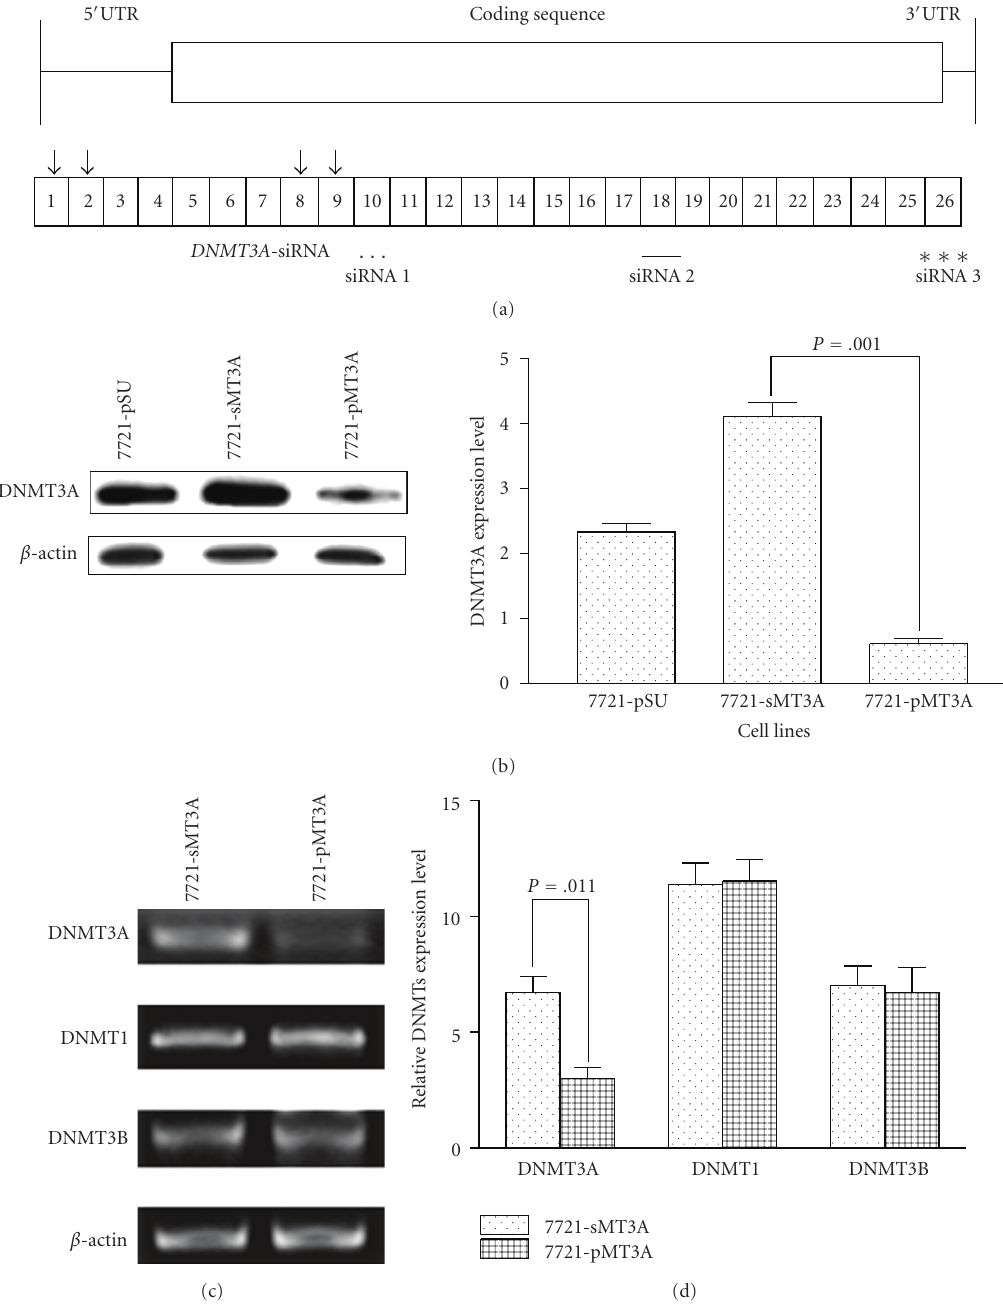
Figure 2: DNMT3A gene expression is inhibited by siRNA of DNMT3A in SMMC-7721 cells. (a) Schematic representation of DNMT3A mRNA structure and siRNA positions is showed. (b) Western blot analysis e ffi ciency of DNMT3A siRNA, β -actin was used as reference control. Lanes 1–3 indicated the cell line transfected with plasmid pSUPER-EGFP, sMT3A, and pMT3A, respectively. Right: the intensity ratios of both target gene band and control from the same sample were determined and calculated by Gel-Pro Analyzer 3.0 . (c) RT-PCR evaluated the a ff ect of DNMT3A -specific siRNA on other DNMTs expression. (d) Real-time quantitative RT-PCR confirmed the e ffi ciency of DNMT3A -specific siRNA and the a ff ect on other DNMTs mRNA